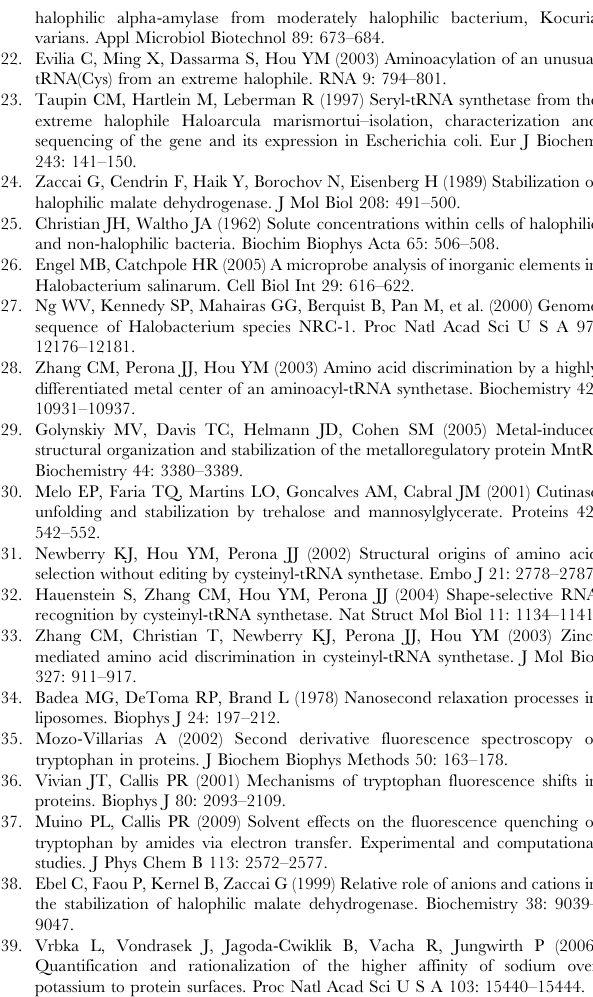
Figure S1 CD signal of NRC-1 CysRS in ZnCl 2 at 222 nm. CD ellipticity of 1 m M NRC-1 CysRS in various concentrations of ZnCl 2 at 222 nm. The standard deviation of three separate spectra is shown as error bars. Figure S2 CD signal of E. coli CysRS in KCl at 222